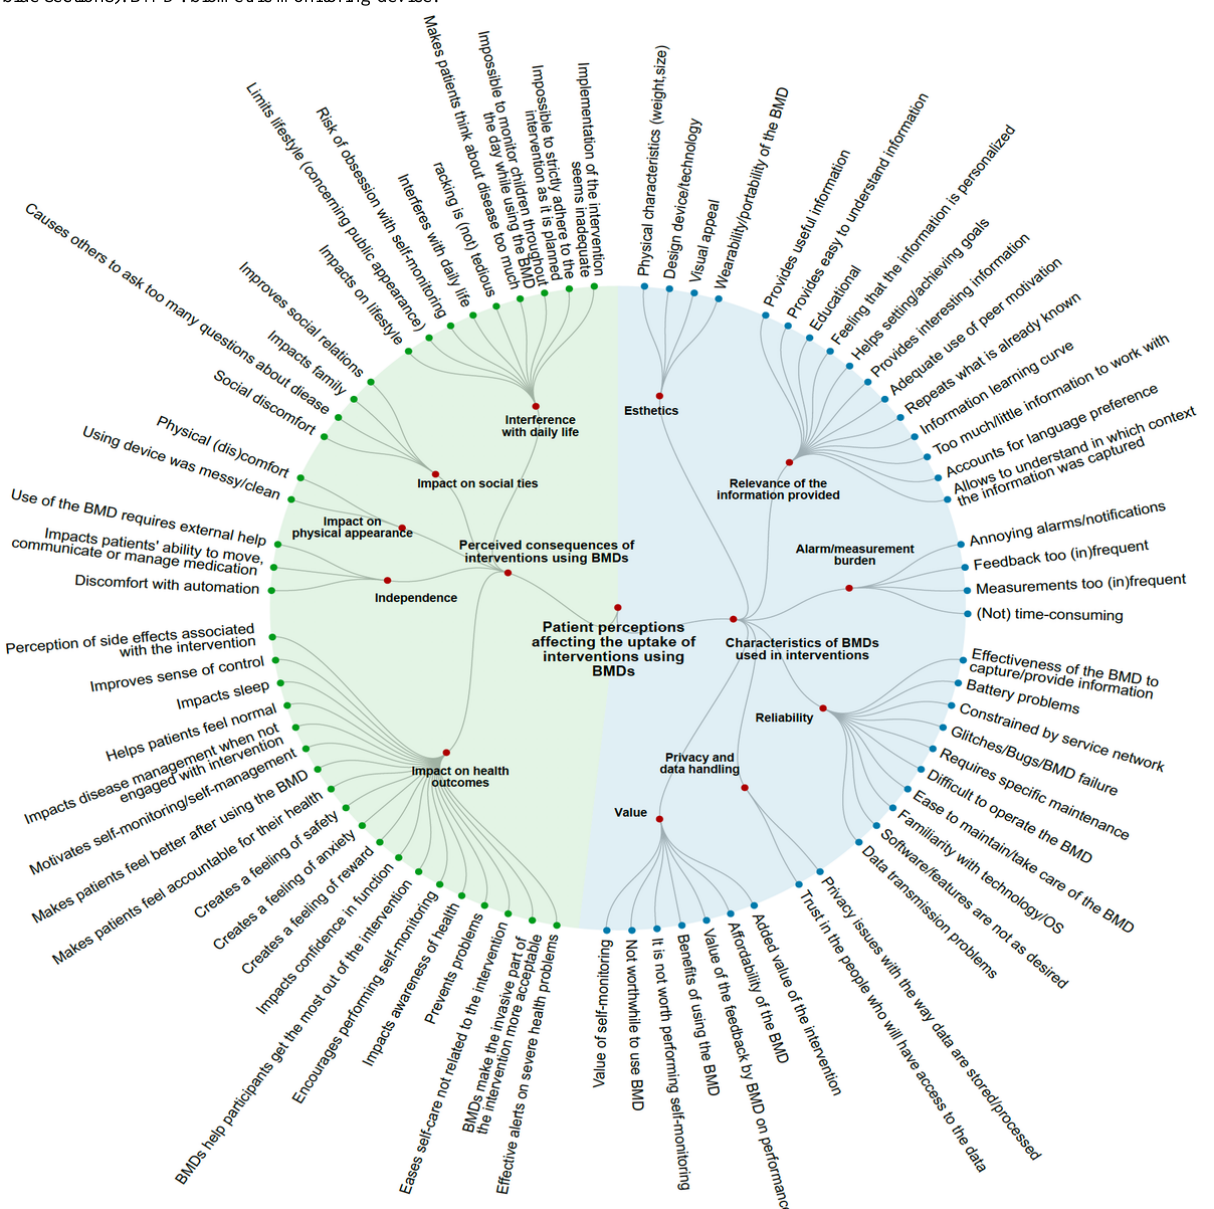
Figure 2. Schema of the 76 specific patient perceptions that could affect the uptake of interventions using BMDs. Specific perceptions are represented by blue nodes around the figure and organized in subcategories (outer red nodes) and major categories (inner red nodes dividing the circle into green and blue sections). BMD: biometric monitoring